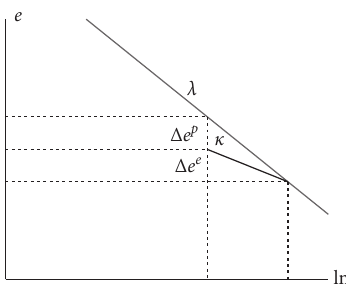
Figure 5: Changes in void